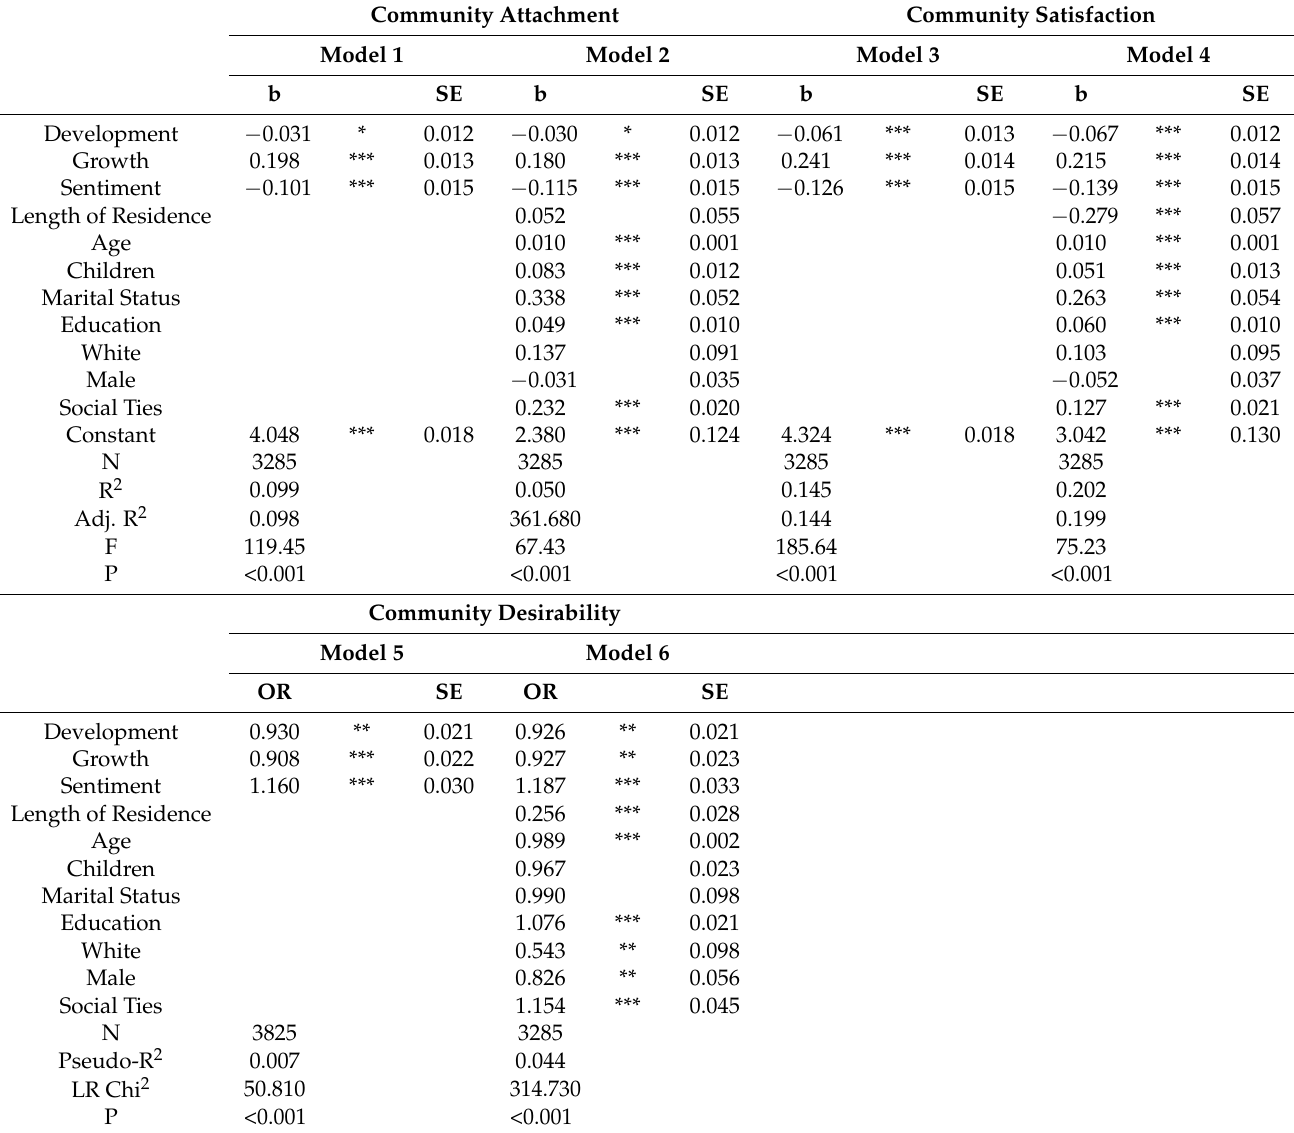
Table 6. Change in Community Sentiments Predated with Textual Factors. Community Attachment Community